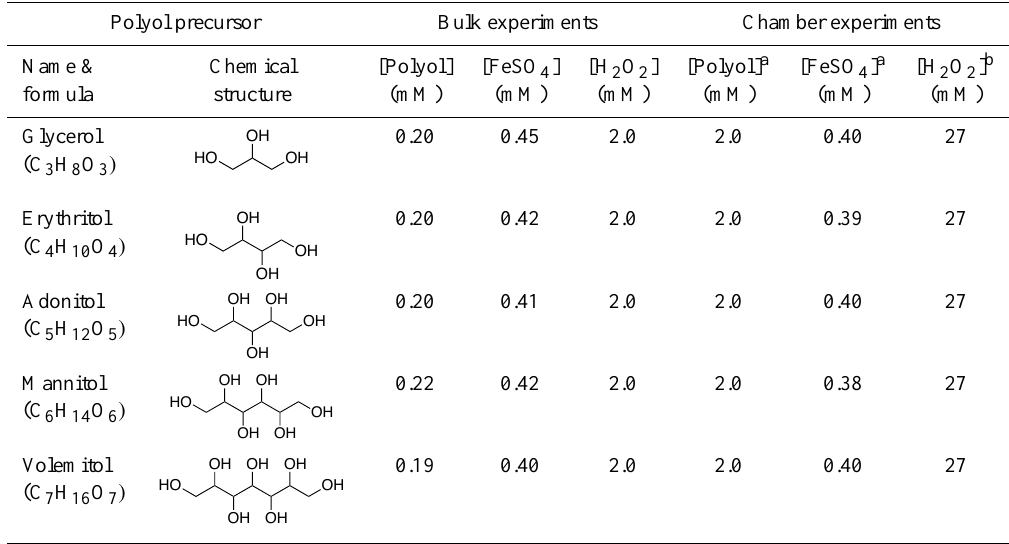
Table 1. Initial concentrations of reactants in the atomizer